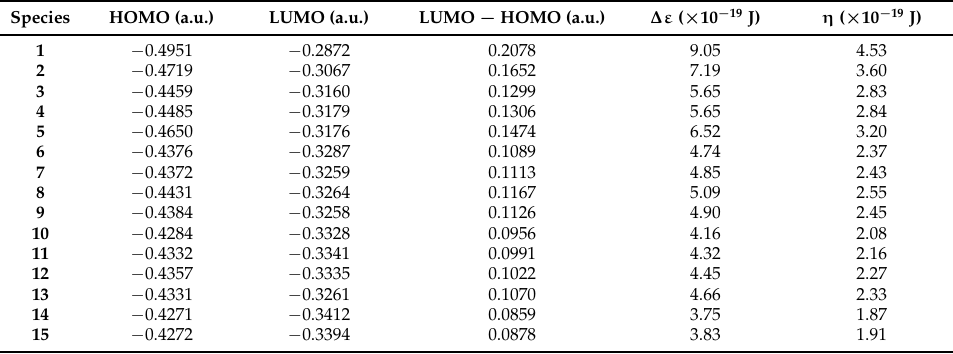
Table 2. Frontier molecular orbital energies and hardness of the tropylium ion and its mono- and poly-phospha analogues.